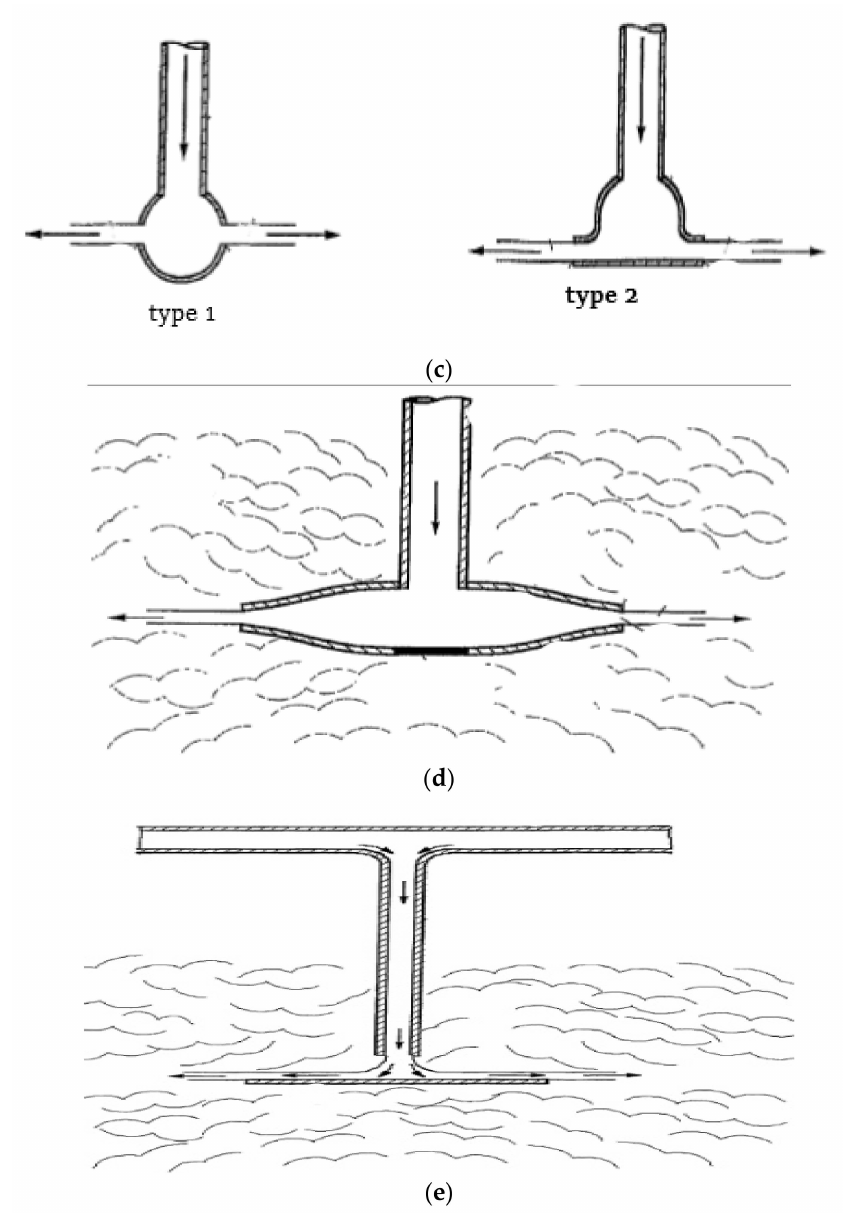
Figure 3. Wash-water distribution nozzles, ( a ) Nozzles that cover the whole froth surface area [30]; ( b ) Angled nozzle; ( c ) Disc type nozzle; ( d ) Chamber type nozzle; ( e ) Flat nozzle